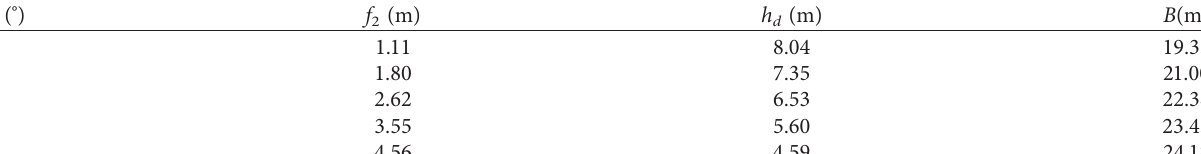
Table 5: Geometrical parameters corresponding to different opening angles φ